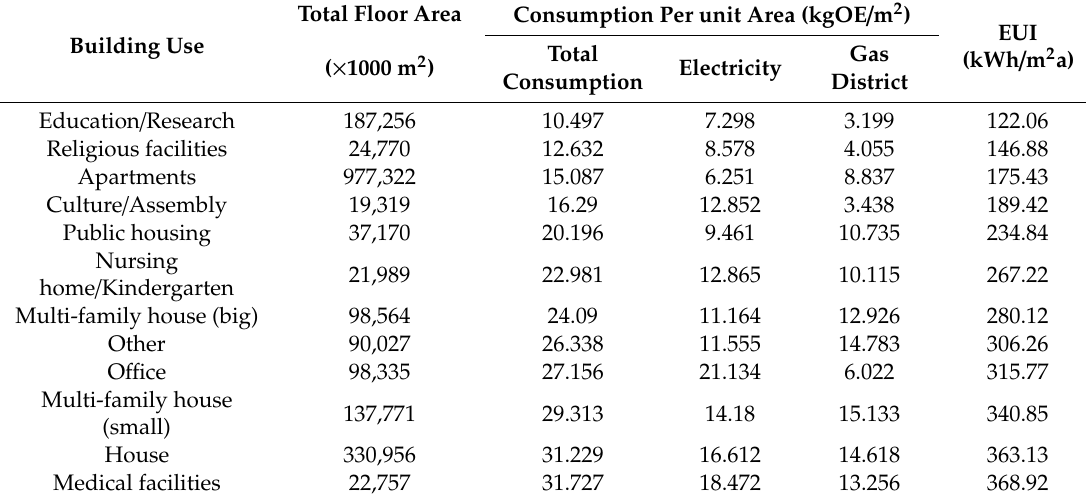
Table 6. 2012 Energy Consumption by Building Use and Energy Sources of Seoul,